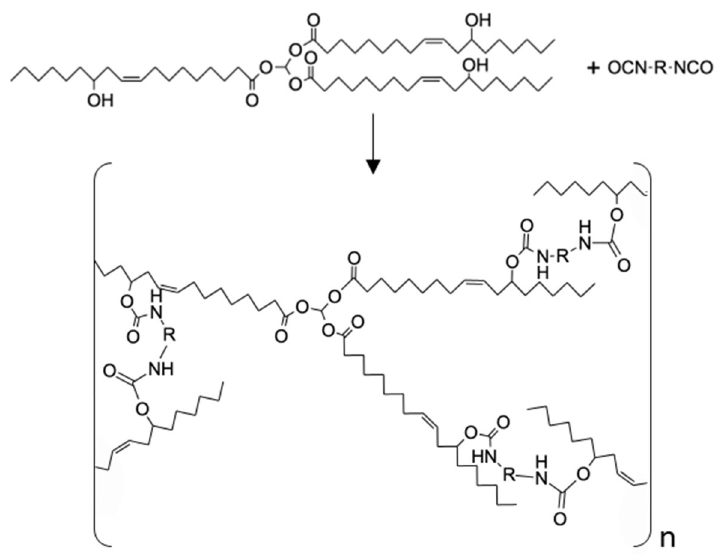
Figure 1. Schematic representation of the formation of polyurethanes from a triglyceride composed by three units of ricinoleic acids (representing castor oil) and a diisocyanate.